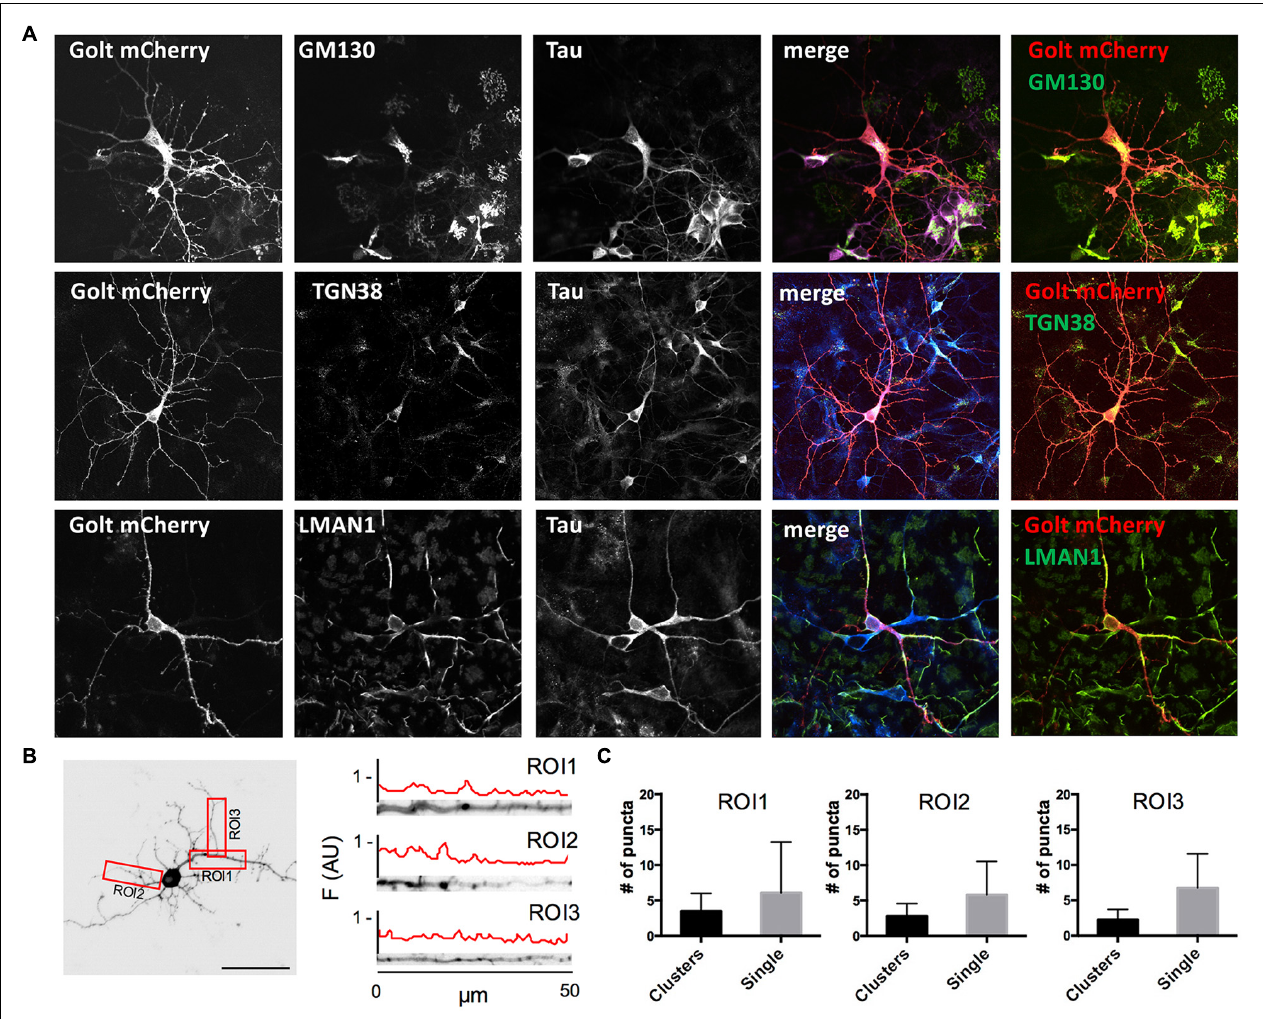
FIGURE 1 | Characterization of pGOLT signals in hippocampal neurons cultured for 7 days in vitro . (A) Representative confocal images of pGOLT-mCherry transfected neurons (red), Tau cytoskeletal marker (blue) combined with immunofluorescence (green) for either Golgi marker GM130 (top) , trans- Golgi network marker TGN38 (mid) , or endoplasmic reticulum marker LMAN1 (bottom) . Transfected neurons present a diffuse and spotted pGOLT-mCherry expression, with high intensity staining in the somatic region. Scale bars = 5 µ m. (B) Left . Image converted in gray levels and B/W inverted of one neuron expressing low pGOLT levels. Each red rectangle represents a 50 µ m-long region of interest (ROI). ROI1 corresponds to the proximal part of the apical dendrite; ROI2 to the proximal part of basal dendrite; and ROI3 to a higher order process. (B) Right . Straightened dendrites presenting several pGOLT spots of variable dimensions. Fluorescence is analyzed as arbitrary units in each segment by an intensity profile plot [F(AU), red line]. Peaks of the intensity plot profile coincide with pGOLT-related vesicles. (C) Average number of persistent pGOLT clusters or single puncta per segment in unstimulated neurons. RO1 = proximal apical, RO2 = proximal basal, RO3 = distal apical. N = 10 neurons per each